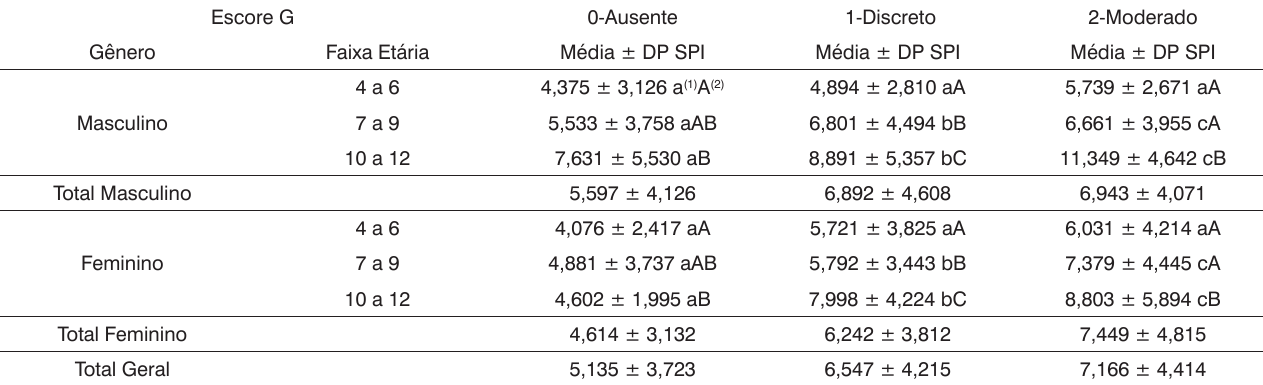
Tabela 12. Valores médios e desvio padrão (DP) de SPI e correlação com o escore do parâmetro G da escala GRBASI, o gênero e a faixa etária (em anos).